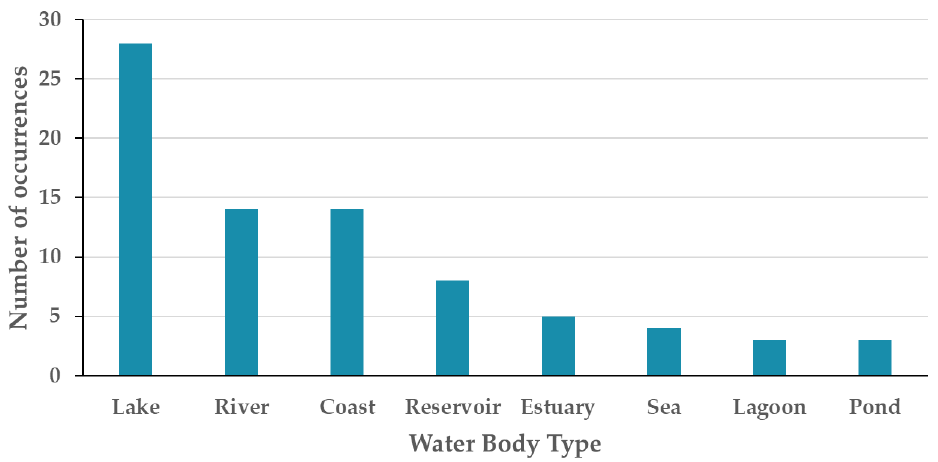
Figure 6. Overview of the water body types in the studies under examination.